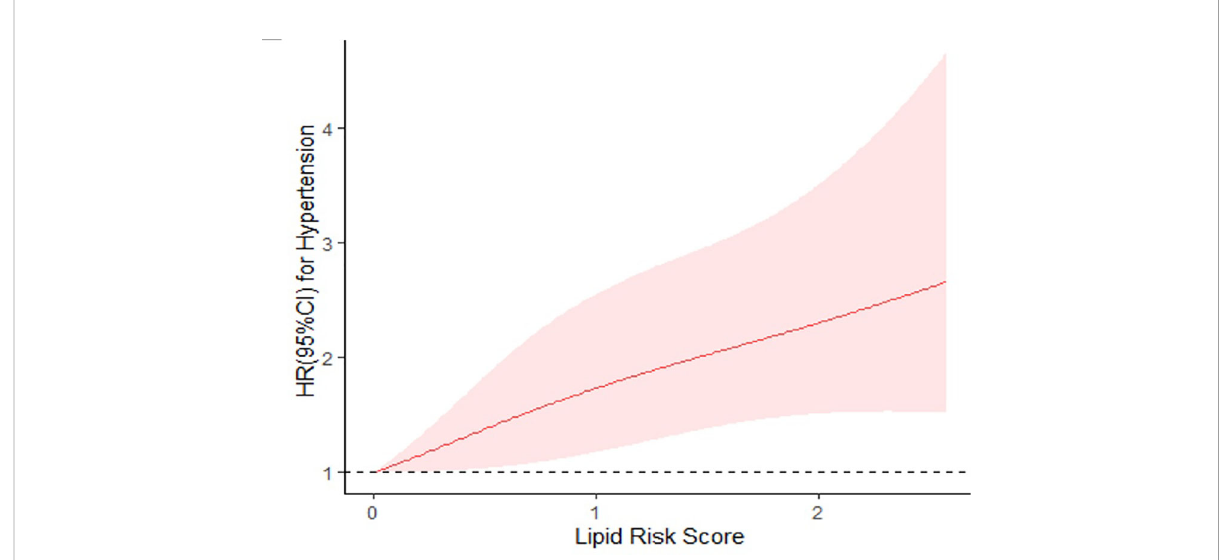
FIGURE 1 Restricted cubic spline regression of lipid risk score and hypertension. HRs are indicated by solid lines and 95% CIs by shaded areas. HR, hazard ratio; CI, con fi dence interval. Adjusted for age, gender, smoking, drinking, hypertension family history, diabetes at baseline, body mass index. P for overall association< 0.01; P for non-linearity = 0.4107; P for linear trend< 0.001.